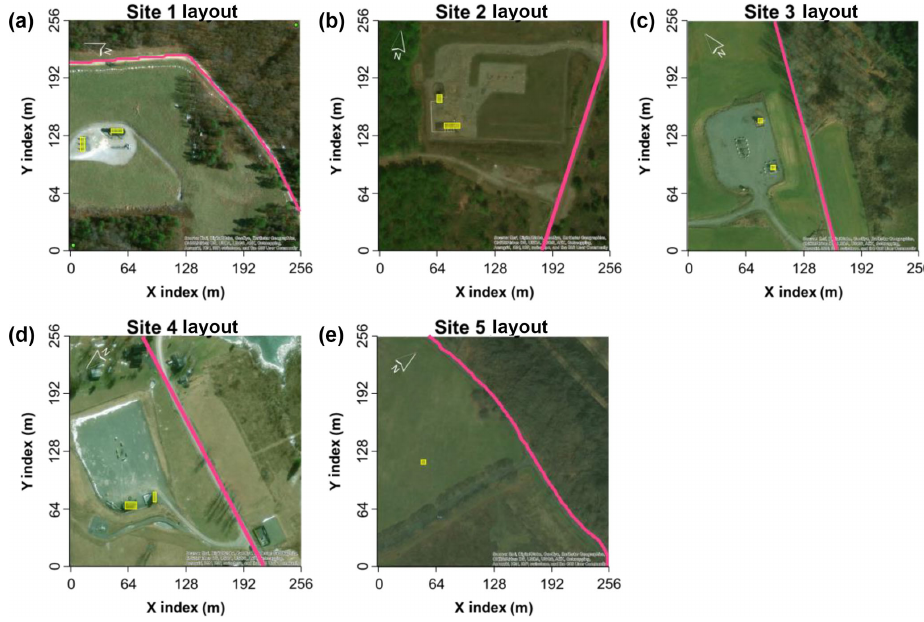
Figure 3. Site layouts showing emitting structures in yellow and the road in magenta for (a) Site 1, (b) Site 2, (c) Site 3, (d) Site 4 and (e) Site 5. Wind is always entering the domain from the left. Table 3. Summary of LES site conditions and